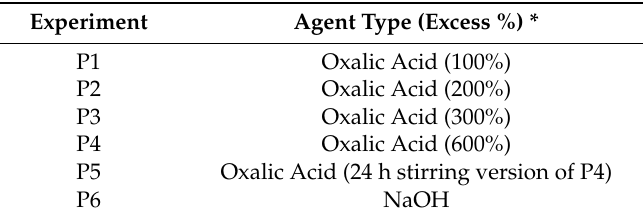
Table 5. Precipitation